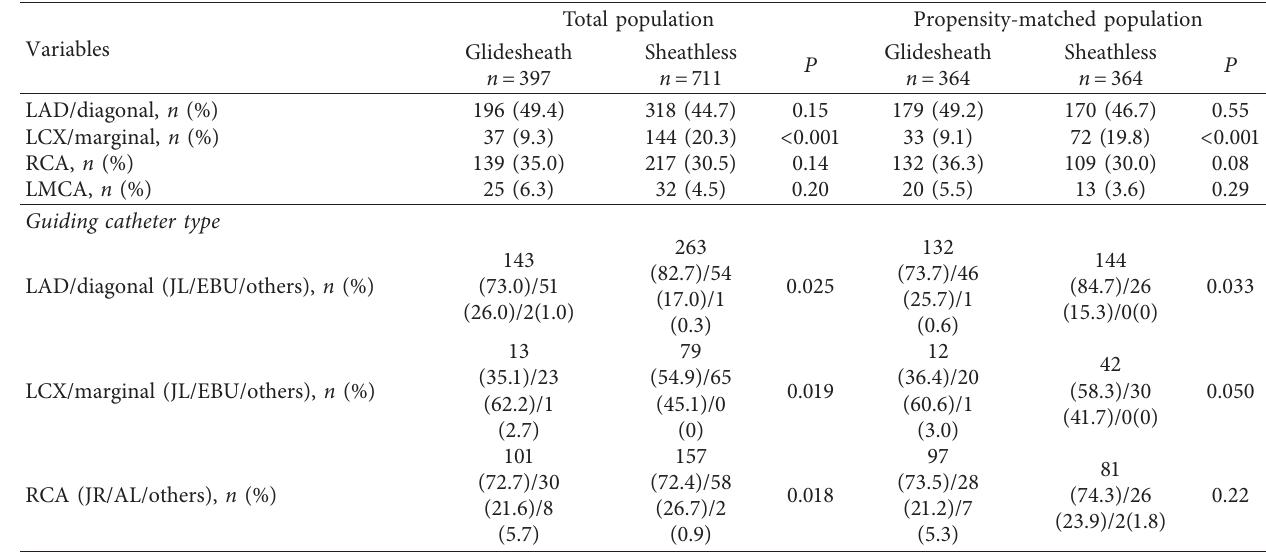
Table 2: Procedural characteristics of the study